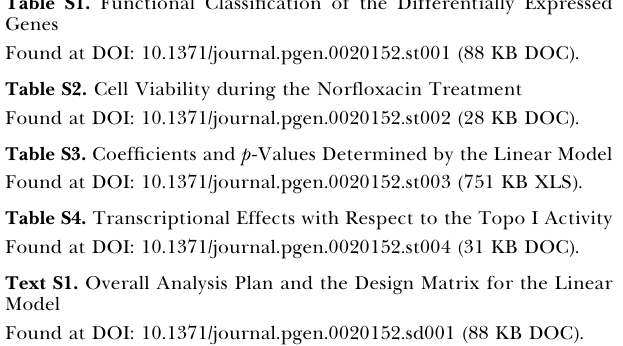
Figure S3. Quantitative Analysis of Relative Transcript Levels by RT- PCR